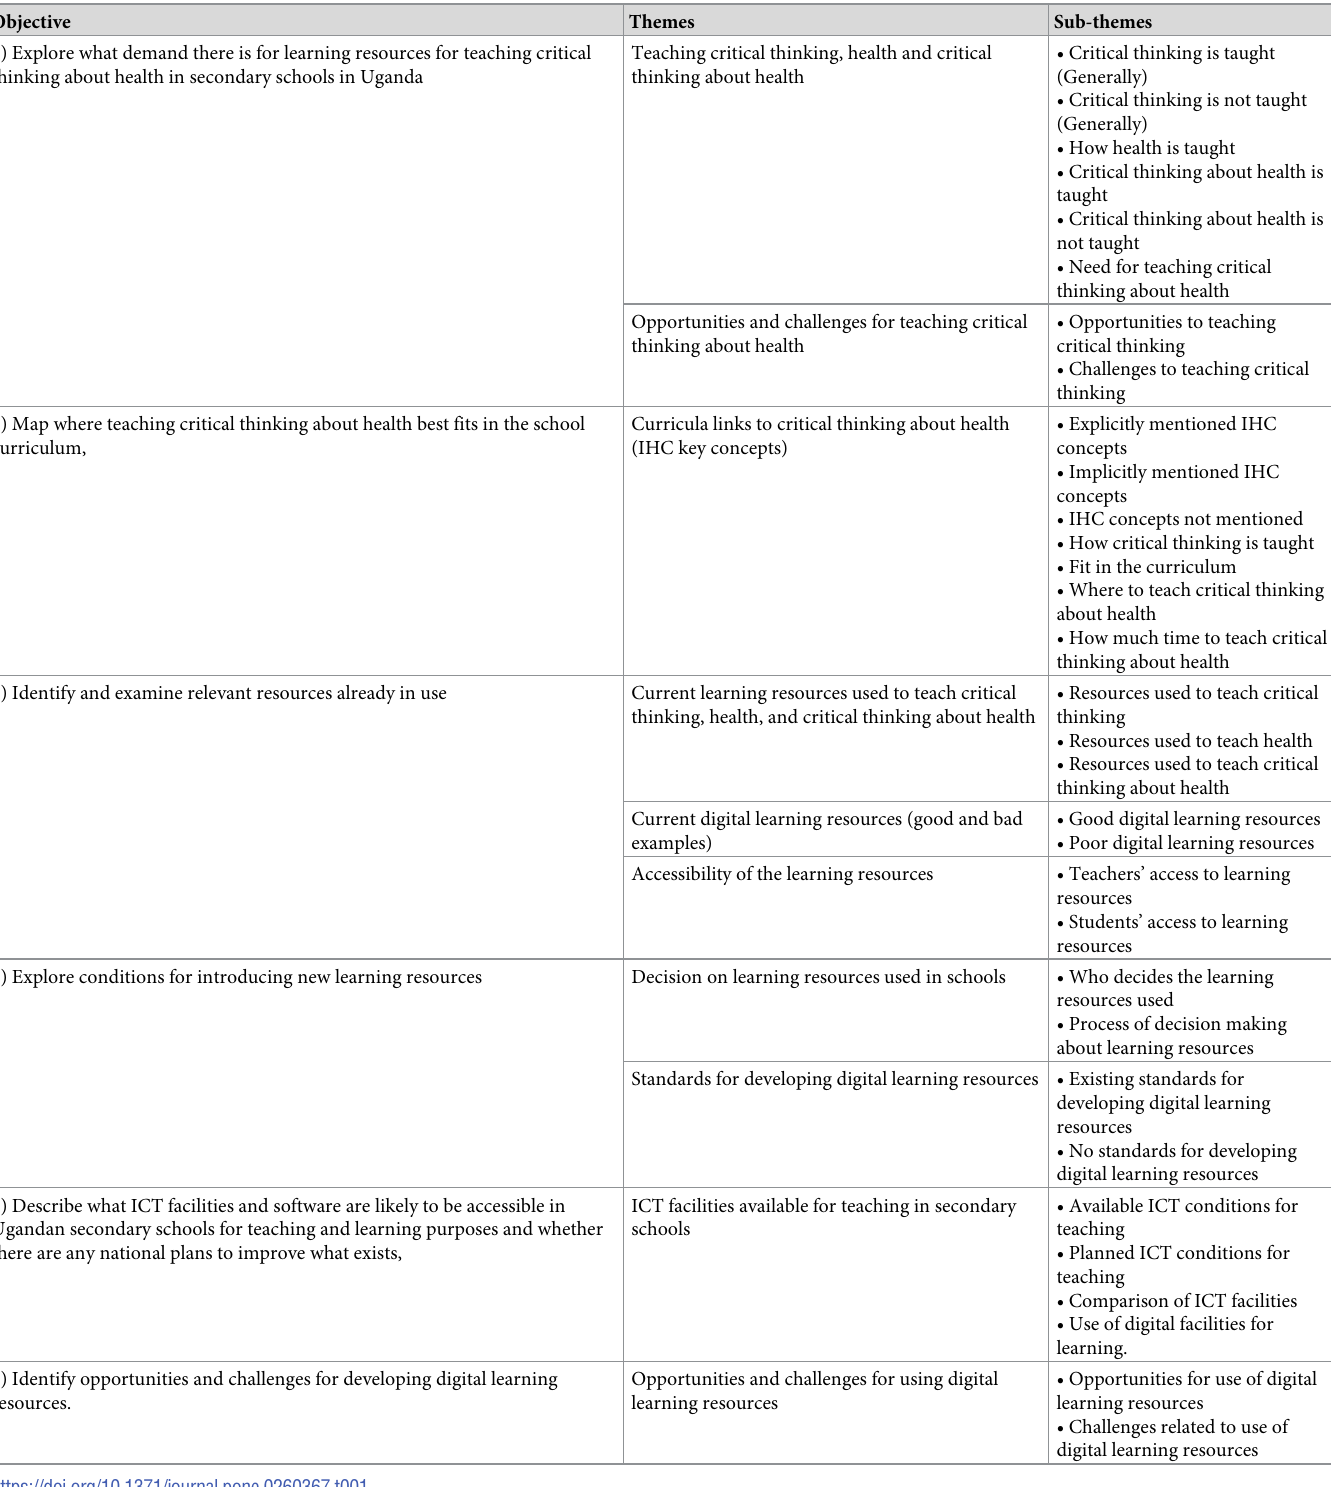
Table 1. Codes used to analyze data from document analysis, key informant interviews and focus group